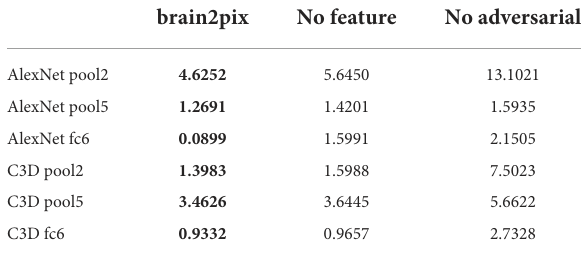
TABLE 6 Ablation experiment distance values